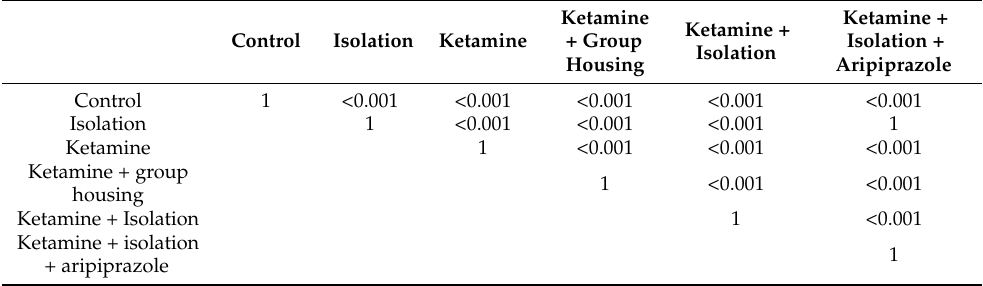
Table 8. All p -values following the post hoc comparison for the level of GPx in the hippocampus.